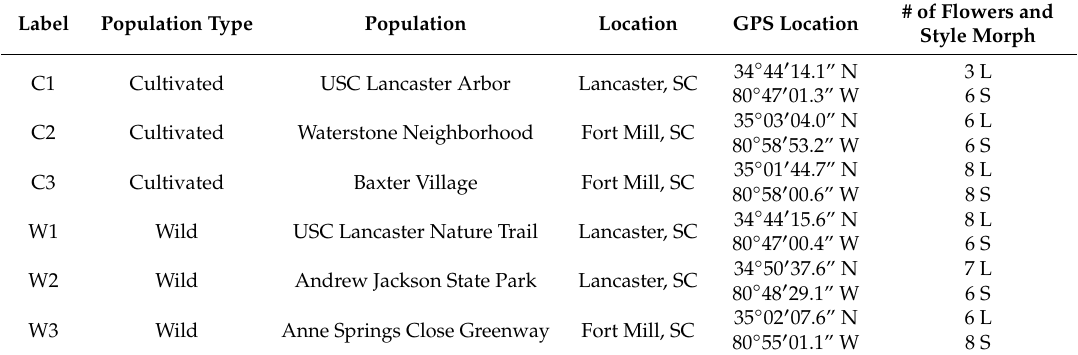
Table 3. Locations of wild and cultivated populations of Gelsemium sempervirens